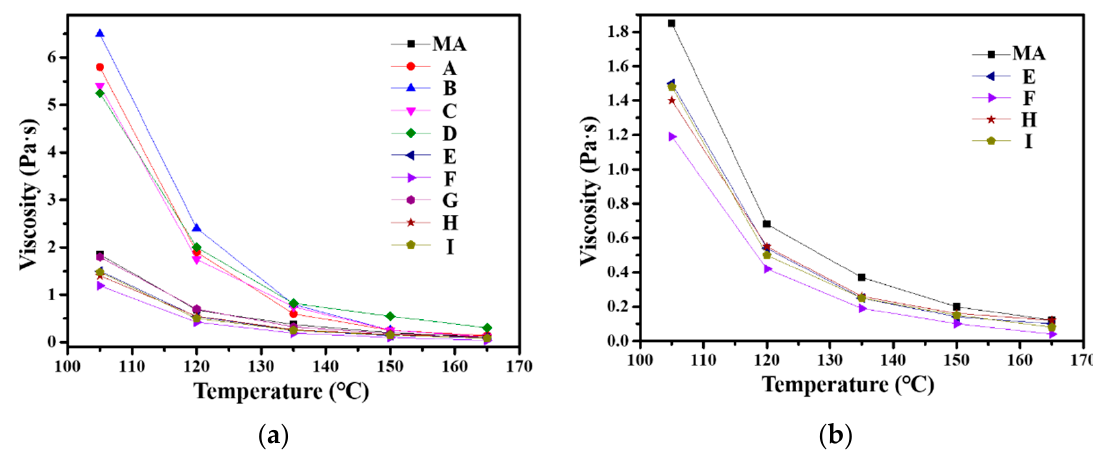
Figure 6. Viscosity–temperature curves of MA and PPWA ( a ). Magnified view of some of the curves ( b ).